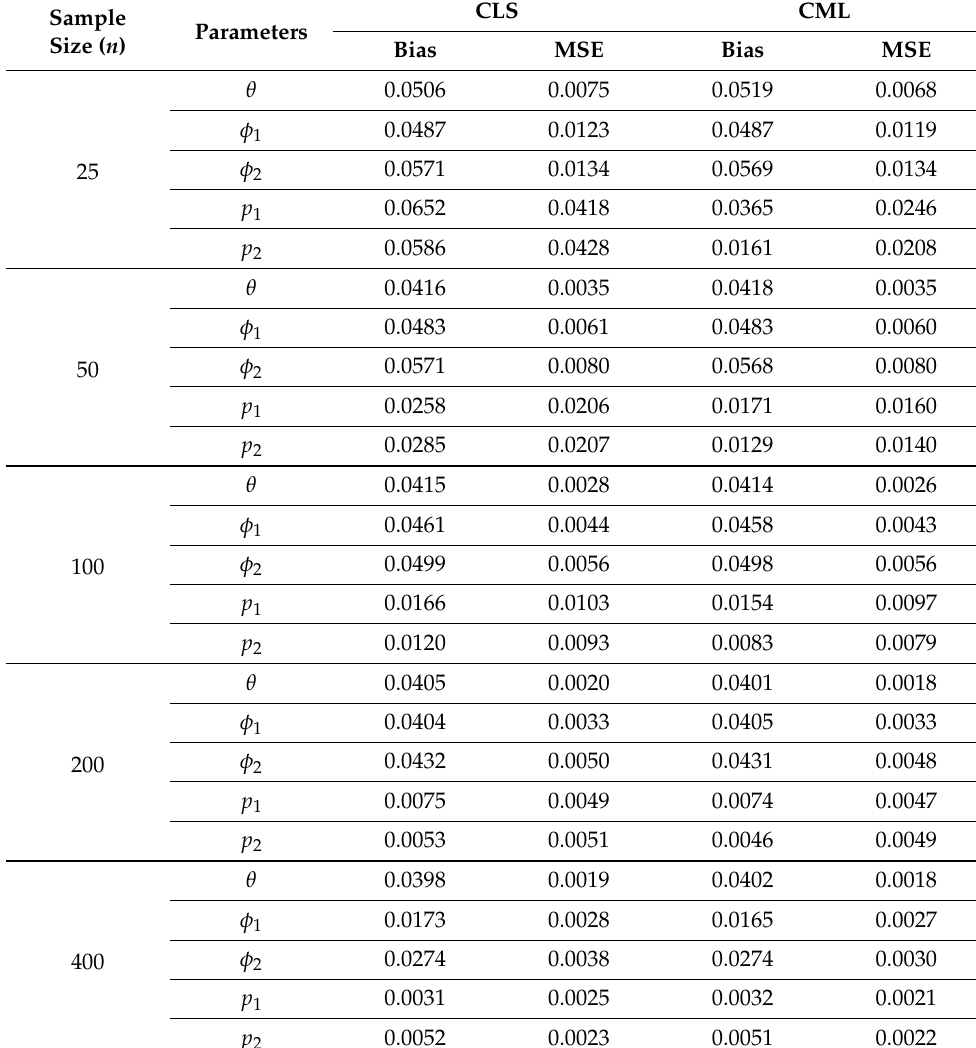
Table 3. Simulation results for the BINAR(1)BP2S-L(I) process for the set of parameter values: